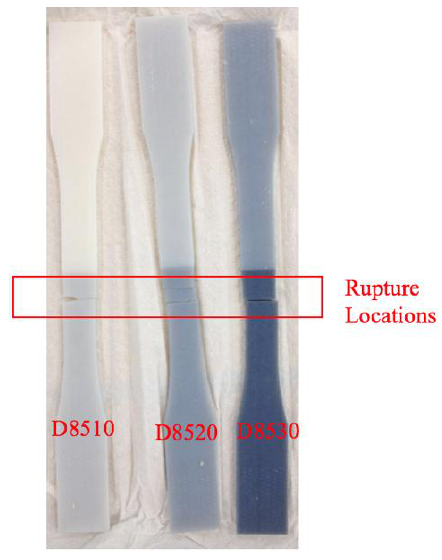
Figure 29. Rupture locations for the Y-axis.